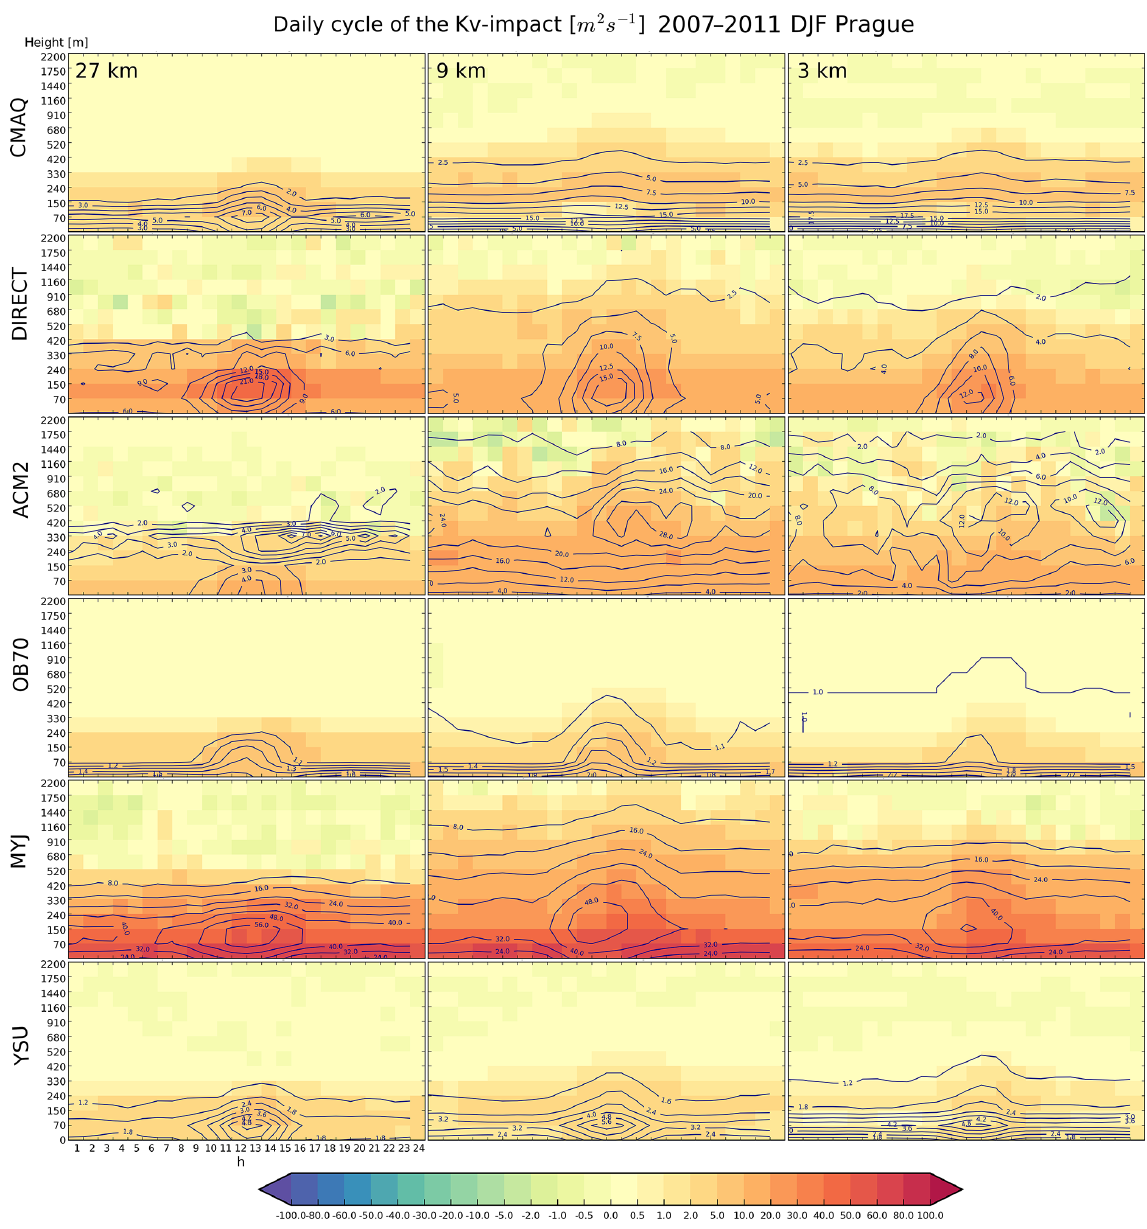
Figure 17. Impact of urban surfaces on the DJF diurnal cycle of the vertical eddy diffusion profile in m 2 s − 1 over Prague for the 27, 9 and 3km domains (columns from left to right). Individual rows represent different K v methods (CMAQ, DIRECT, ACM2, OB70, MYJ and YSU, from top to bottom). Contour lines denote the absolute K v values from the URBAN model